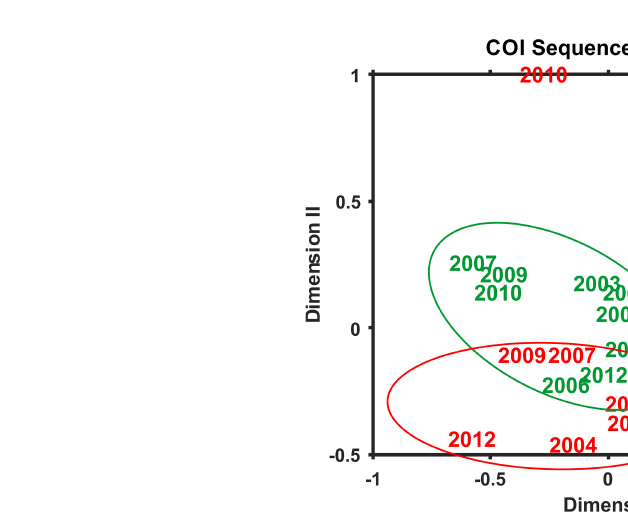
FIGURE 7 | Two-dimensional Nonmetric Multidimensional Scaling (NMDS) analysis of regional variation based on COI sequence numbers for 23 species with total sequence numbers >1000. See Table 2 for list of species. The plot indicates the year of sample collection; colors indicate regions: MAB (red), GB (green), GoM (blue). Note that the MAB 2010 sample is not included within the circle de fi ning the MAB